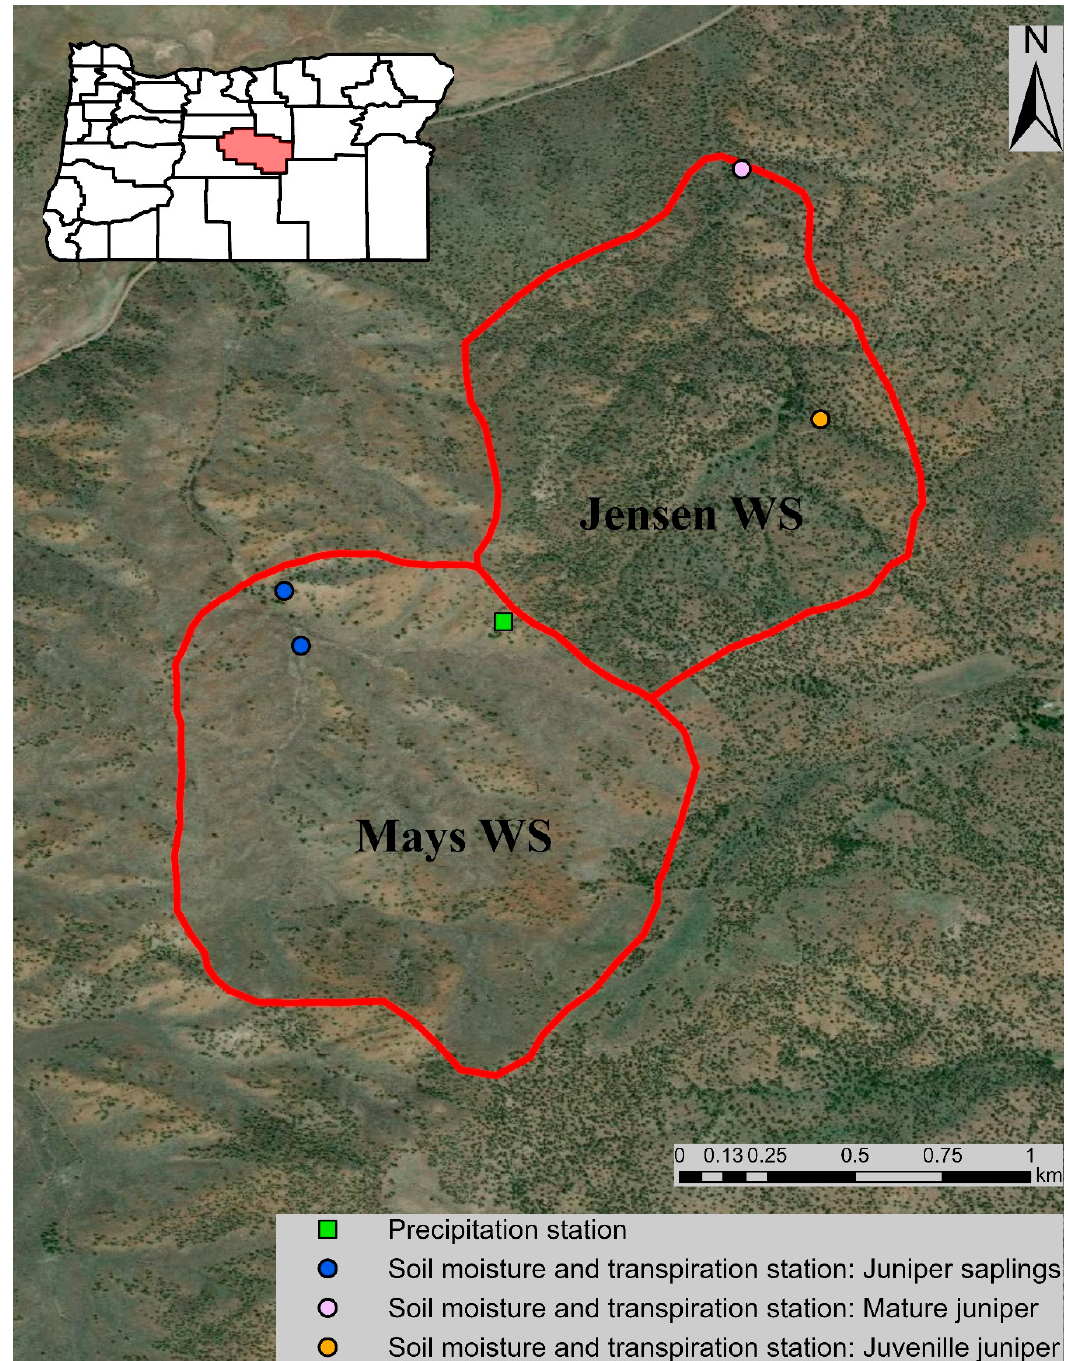
Figure 1. Map of the study area showing Mays WS and Jensen WS, indicating the locations of different monitoring instrumentation used in this study. The monitoring station for mature juniper in Jensen WS is located at 1370 m elevation, in alluvial deposits [60]. The other monitoring stations are located at elevations ranging from 1400 m to 1524 m, in mostly fractured basalt [30,60]. Base map source: Esri,